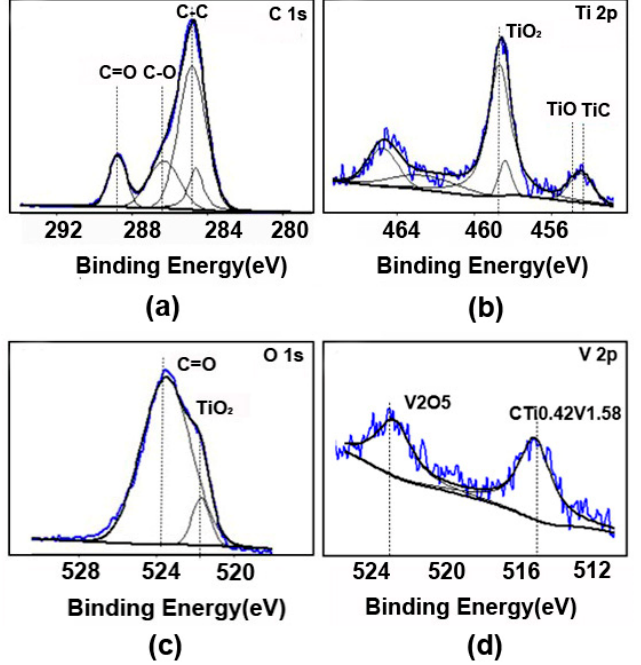
Figure 11. The spectrum schematic image of XPS of Ti-6Al-4V ( a ) the peak of C element, ( b ) the peak of titanium element, ( c ) the peak of O element, and ( d ) the peak of V element.